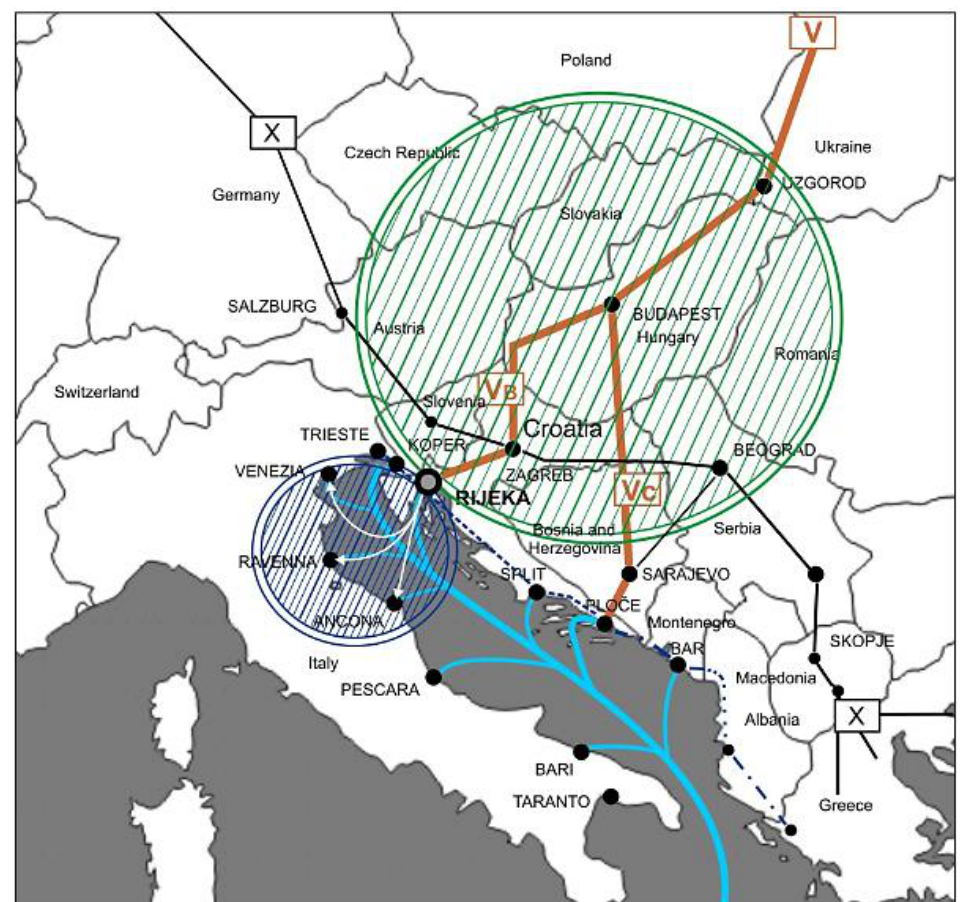
Figure 3. The gravitation area consisting of the hinterland and foreland.